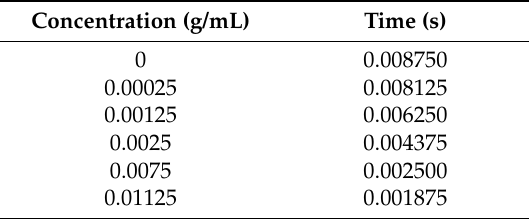
Table 3. Decay time at different concentration values.